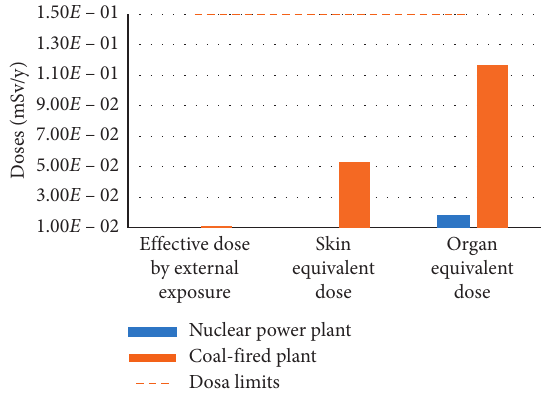
Figure 5: Comparison of dose results between the nuclear and coal-fired power